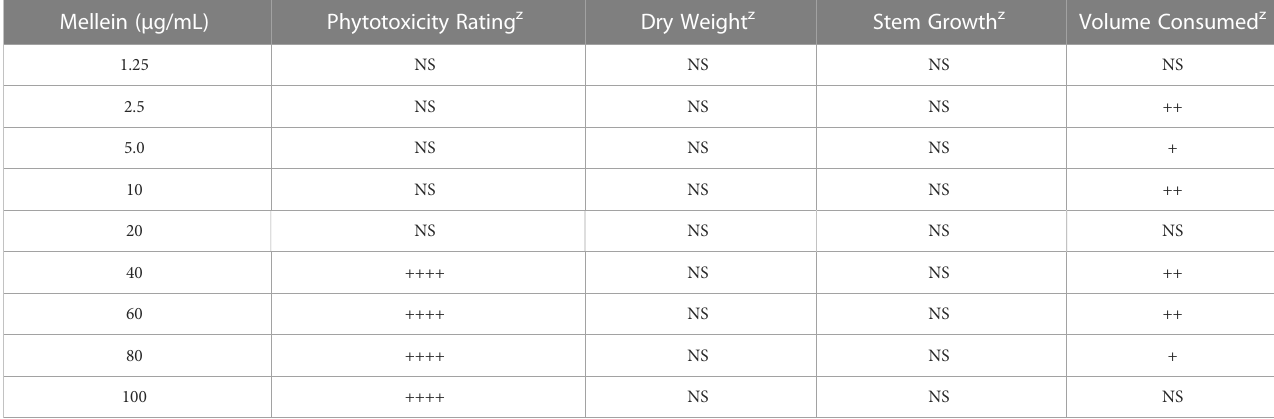
TABLE 3 Phytotoxicity of commercially-available mellein against soybean seedlings, germplasm line DT97-4290, in hydroponic culture. Mellein